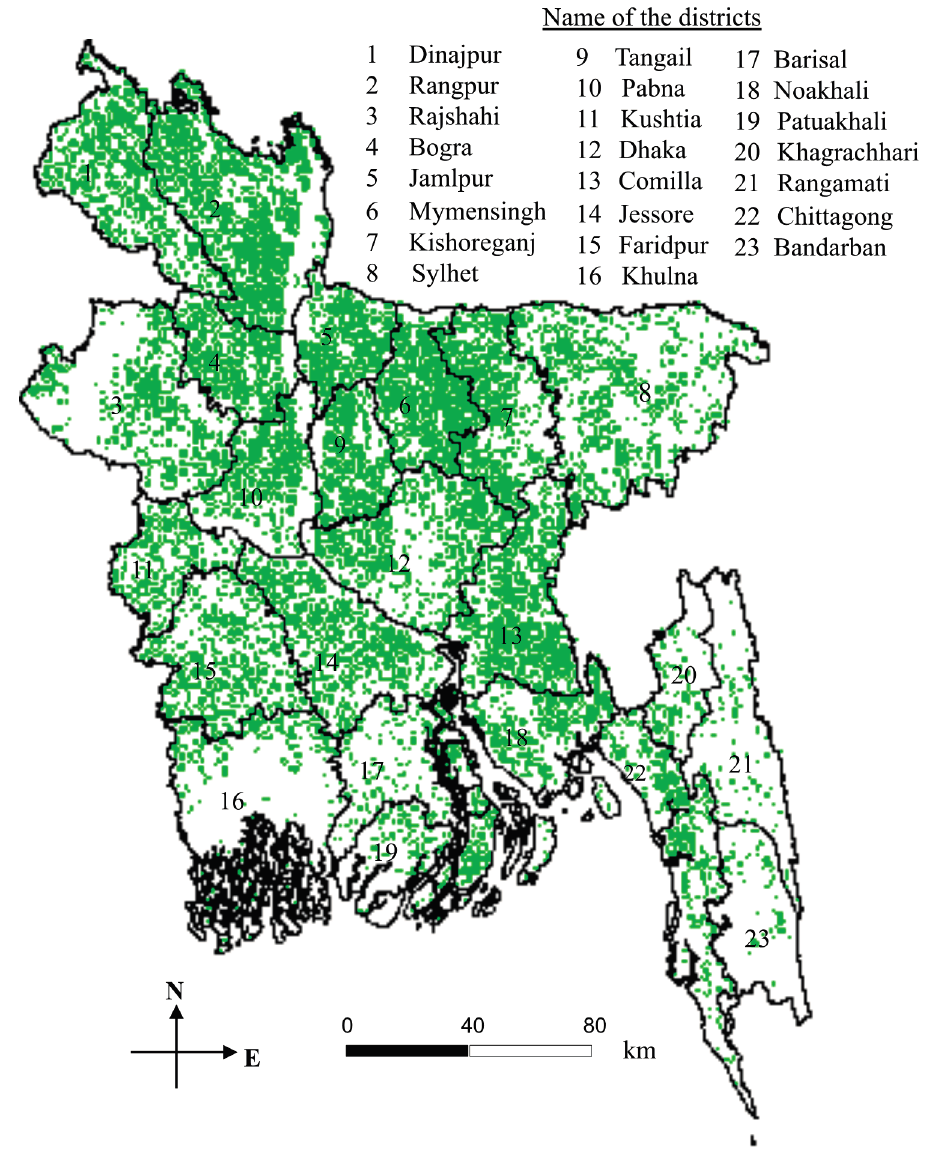
Figure 2. Example of MODIS-derived boro rice cultivation area (indicated using green shades) mapping during